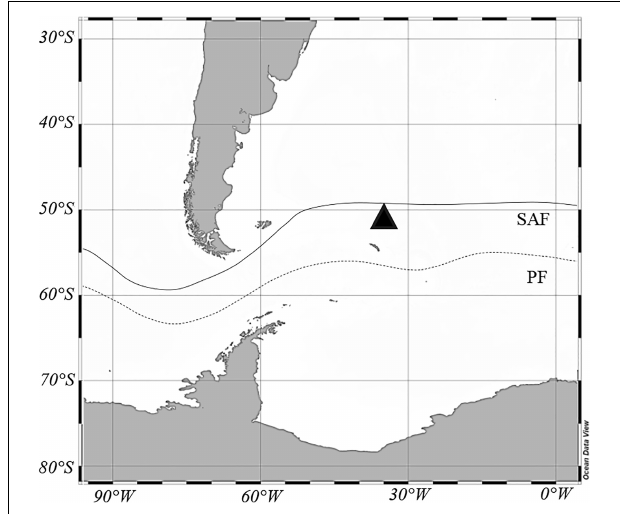
FIGURE 1 | Station where Limacina retroversa was collected on October 30, 2017, in the sub-Antarctic Zone (black triangle). Lines represent mean positions of the sub-Antarctic front (SAF) and the polar front (PF) (Orsi et al.,